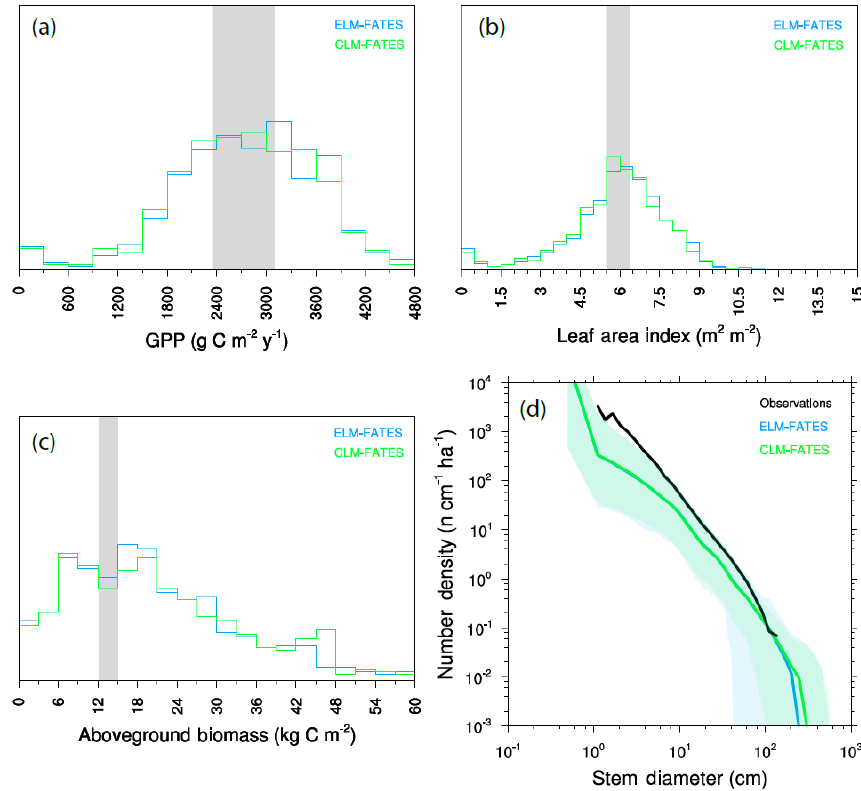
Figure 9. Comparison of FATES simulations as embedded within two land surface models: ELM-FATES and CLM-FATES. (a) GPP, (b) LAI, and (c) aboveground biomass. Observational range shown as grey band in (a) – (c)